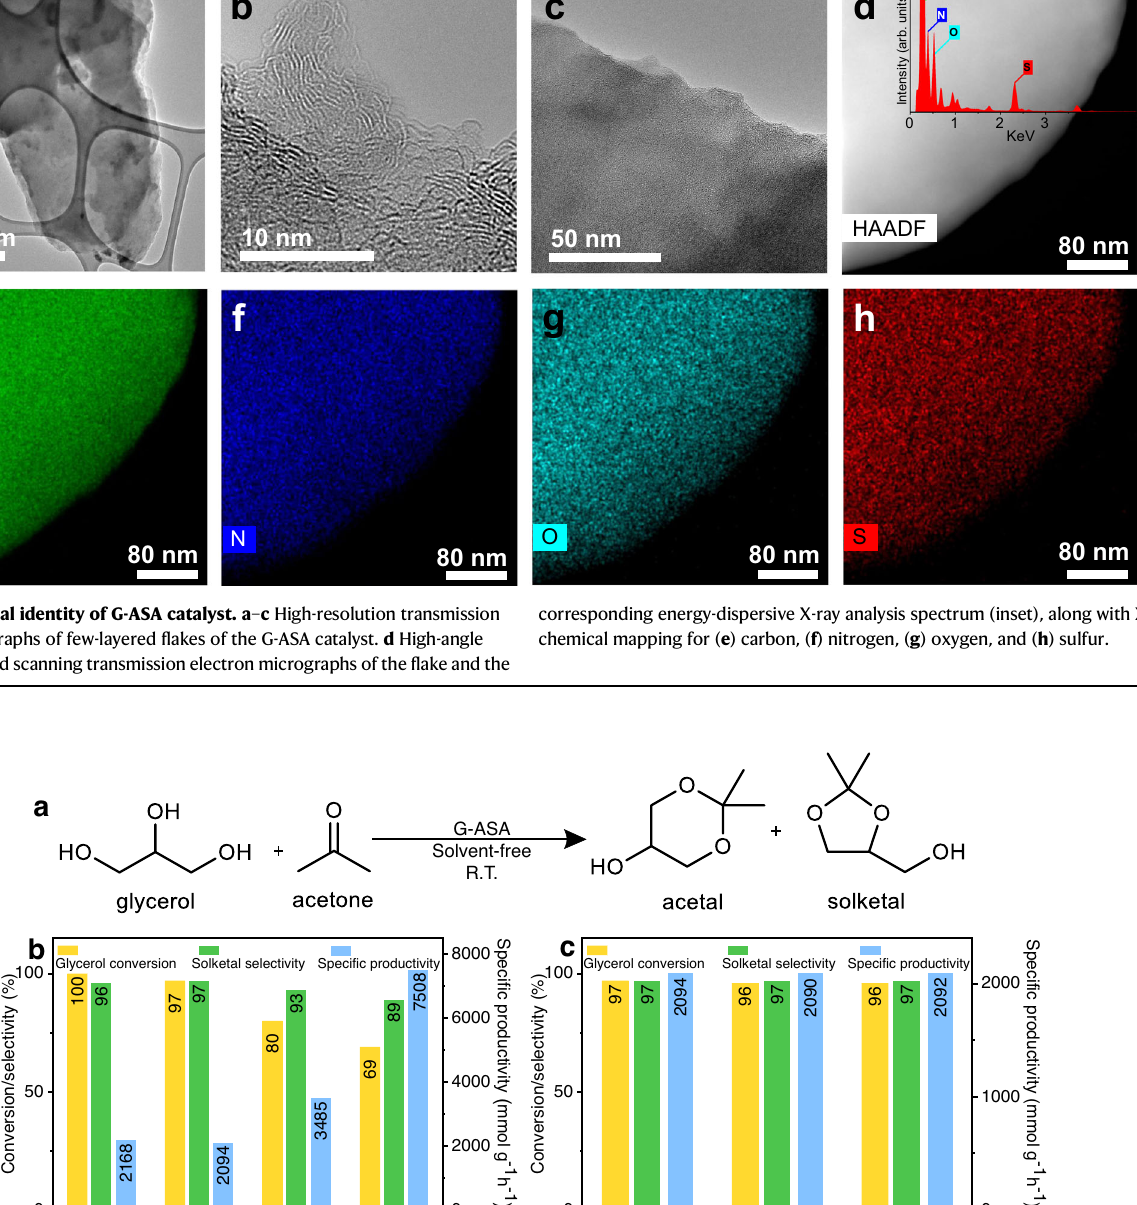
Fig. 3 | Catalytic reaction study. a Acetylation reaction of glycerol with acetone. b Solketal synthesis from glycerol by using the G-ASA catalyst (taurine-functiona- lizedgraphene)withdifferentcatalystmassloadings(mass%)and ( c )recyclability.